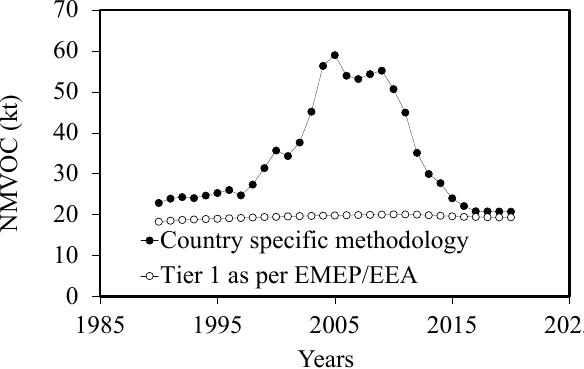
Figure 1. NMVOC emissions from domestic solvent use.